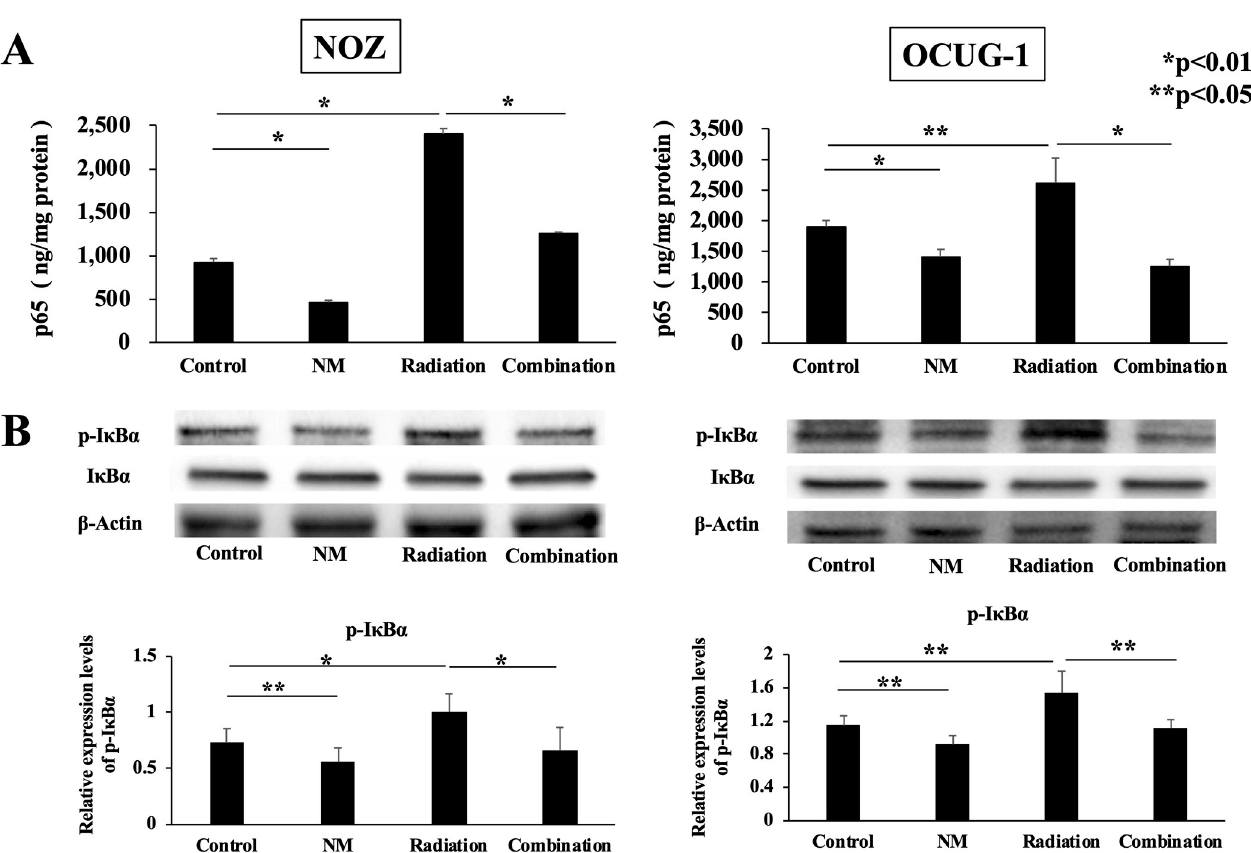
Fig 2. NF- κ B p65 and phosphorylation of I κ B α in vitro . (A) The enzyme-linked immunosorbent assay (ELISA) results showed that p65 concentration in the radiation group was higher than that in the control group (NOZ: 2,398.4 ± 62.8 ng/mg protein vs. 923.5 ± 42.3 ng/mg protein, p < 0.01; OCUG-1: 2,609.3 ± 409.3 ng/mg protein vs. 1,899.5 ± 99.5 ng/mg protein, p < 0.05). p65 concentration in the combination group was lower than that in the radiation group (NOZ: 1,256.1 ± 13.0 ng/mg protein vs. 2,398.4 ± 62.8 ng/mg protein, p < 0.01; OCUG-1: 1,250.9 ± 117.8 ng/mg protein vs. 2,609.3 ± 409.3 ng/mg protein, p < 0.01). (B) Western blotting results revealed that the expression level of phosphorylated I κ B α decreased in the combination group compared with that in the radiation group (NOZ; p < 0.01, OCUG-1; p < 0.05), whereas the expression level of I κ B α increased in the combination group compared with that in the radiation group at 3 h for NOZ and OCUG-1